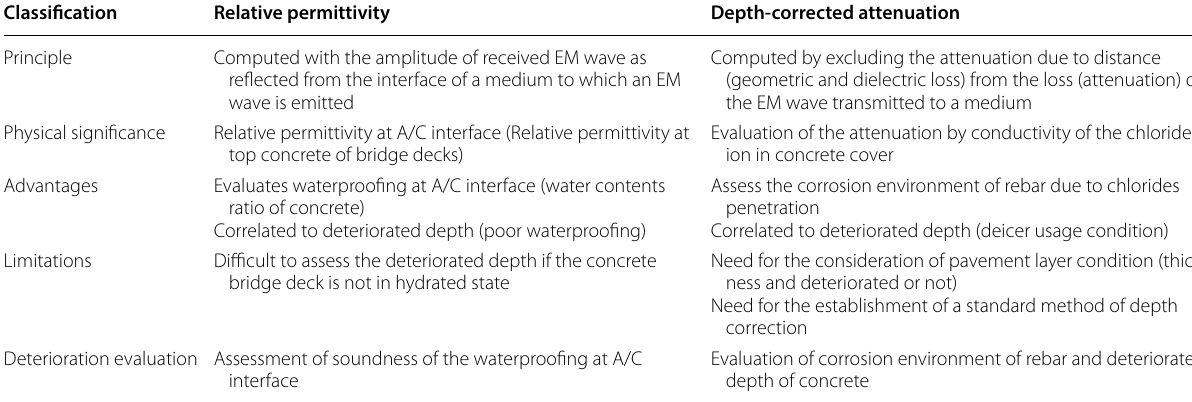
Table 5 Comparison of the two GPR parameters (relative permittivity and depth-corrected attenuation of concrete cover) for the condition assessment of concrete bridge decks with asphalt overlays.